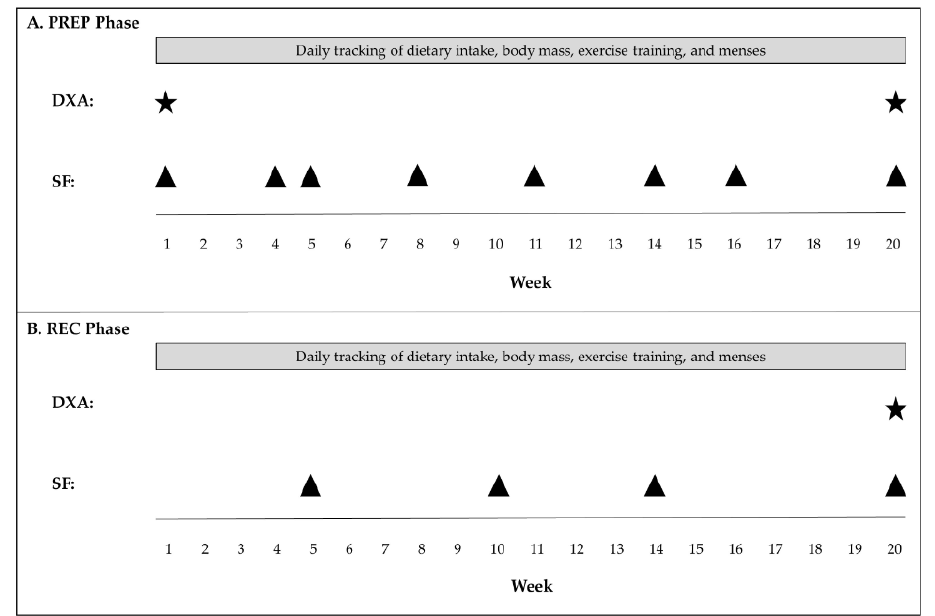
Figure 1. Timeline of Study Measurements ( A ) PREP and ( B ) REC phases. PREP: Competition preparation; REC: Competition recovery; DXA: Dual ‐ energy X ‐ ray absorptiometry; SF: Skinfolds.